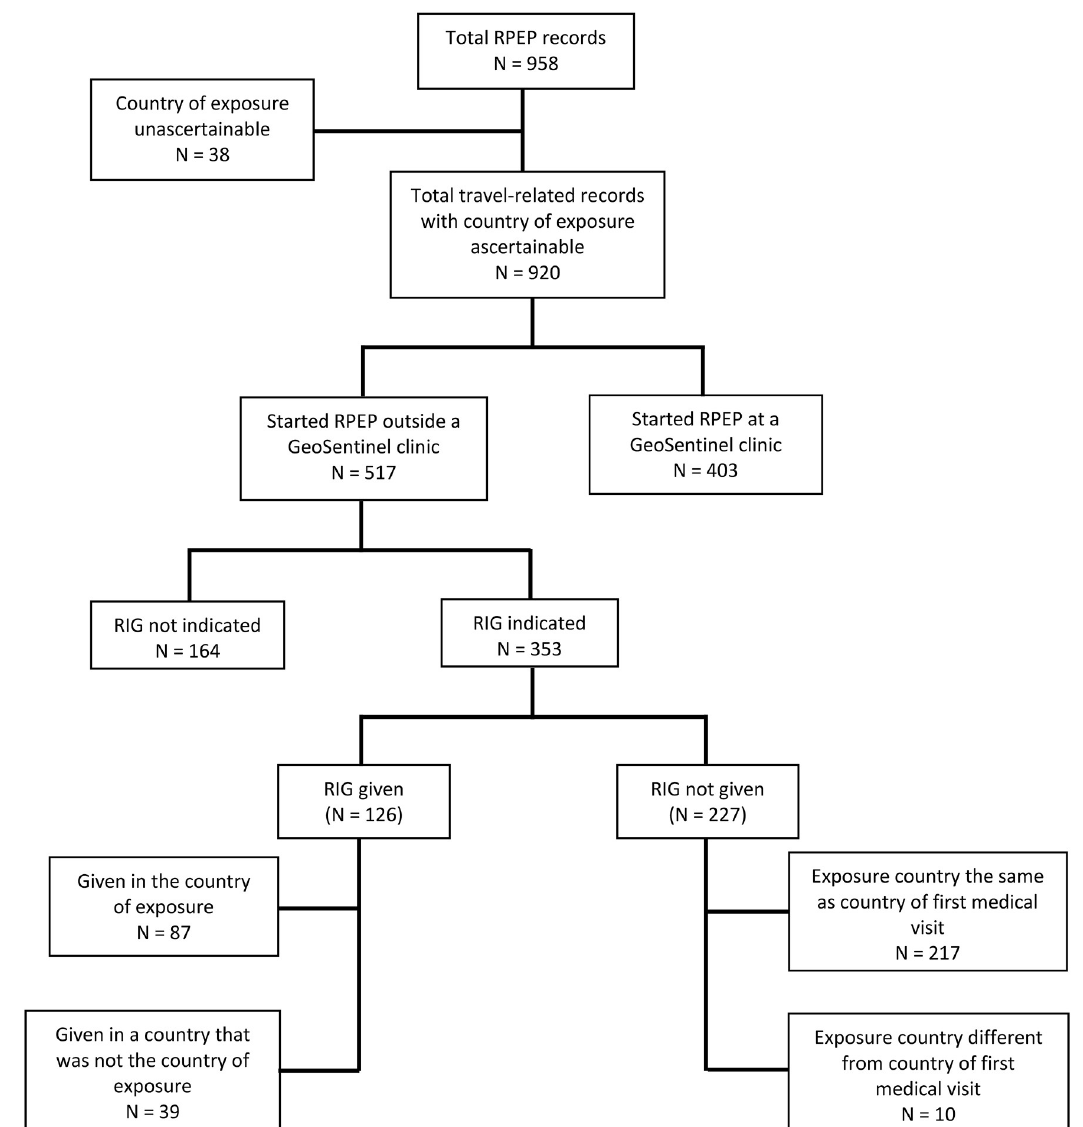
Fig 1. Number of international travelers receiving RPEP reported to GeoSentinel, September 2014–July 2017 (RIG: Rabies immunoglobulin; RPEP: Rabies post-exposure